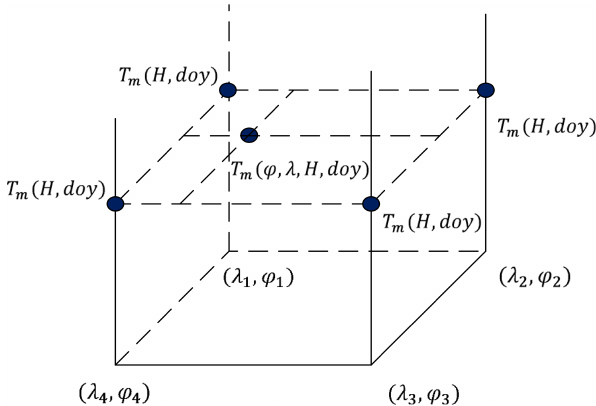
Figure 4. Spatial interpolation of the T m value for the target point ( ϕλH ). After obtaining the T m values at height H at the four grid points (see the four grids on the top plane) by the GGNTm model using Eq. (7), the T m value at the target point can be interpolated (the dashed